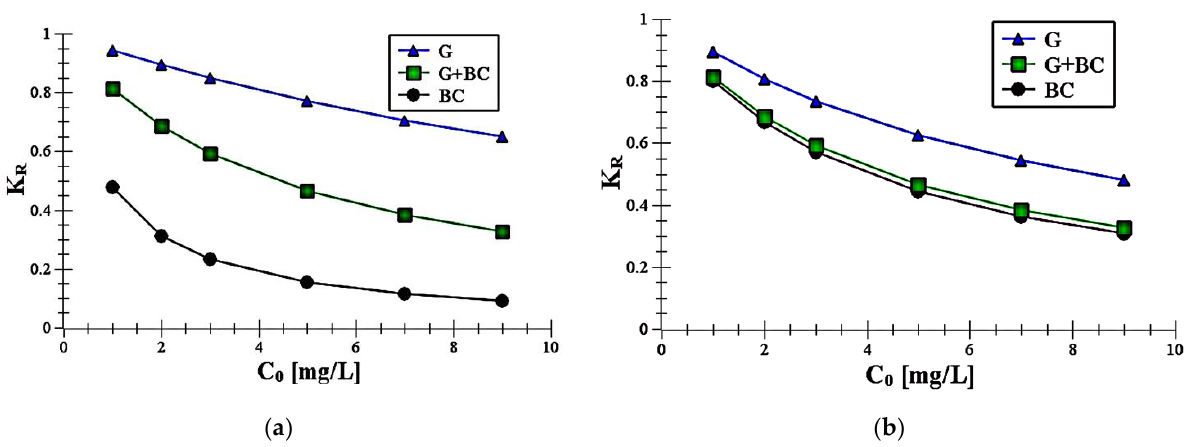
Figure 6. Plot of K R parameter against initial diuron ( a ) and carboxin ( b ) concentration C 0 .